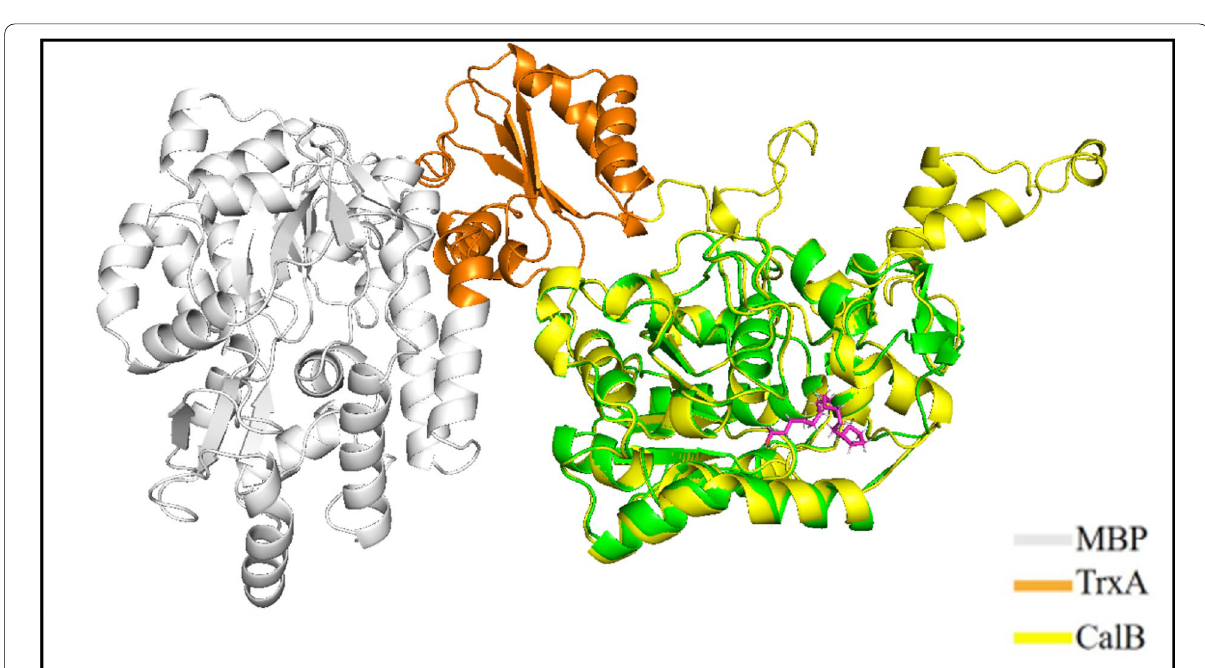
Fig. 6 Comparation of MT‑CalB and